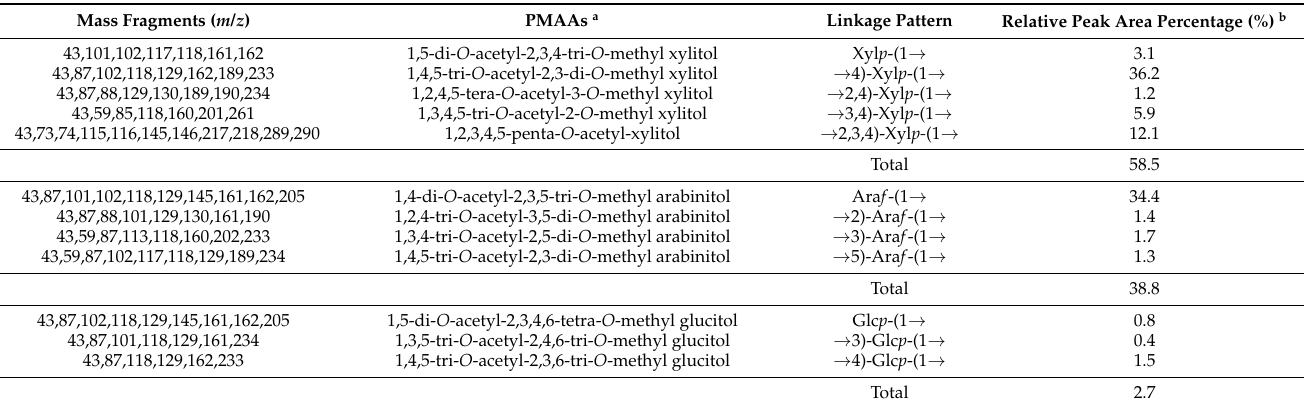
Table 2. Chemical properties and monosaccharide compositions of arabinoxylan from hull-less barley. Mass Fragments ( m / z ) PMAAs a Linkage Pattern Relative Peak Area Percentage (%)